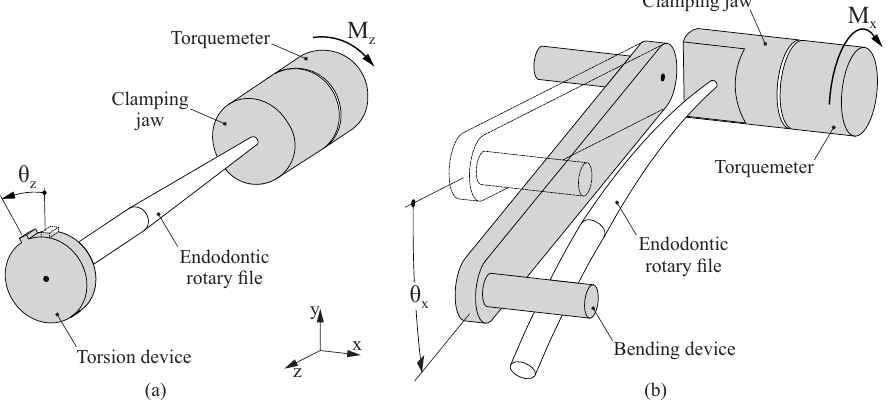
Figure 3. Devices used for torsion ( a ) and bending ( b ) analyses.